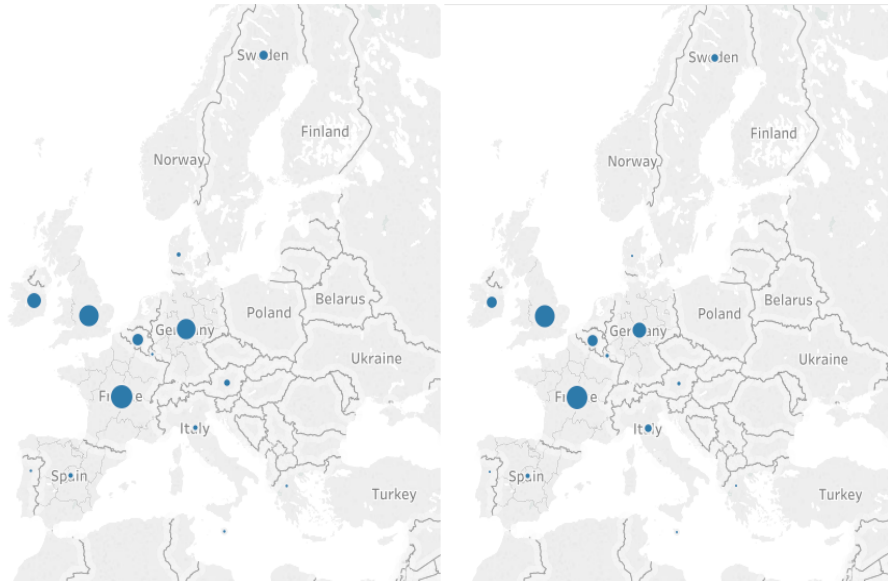
Figure 3. Cluster analysis of Current Professional Certificates in 2016/2018.